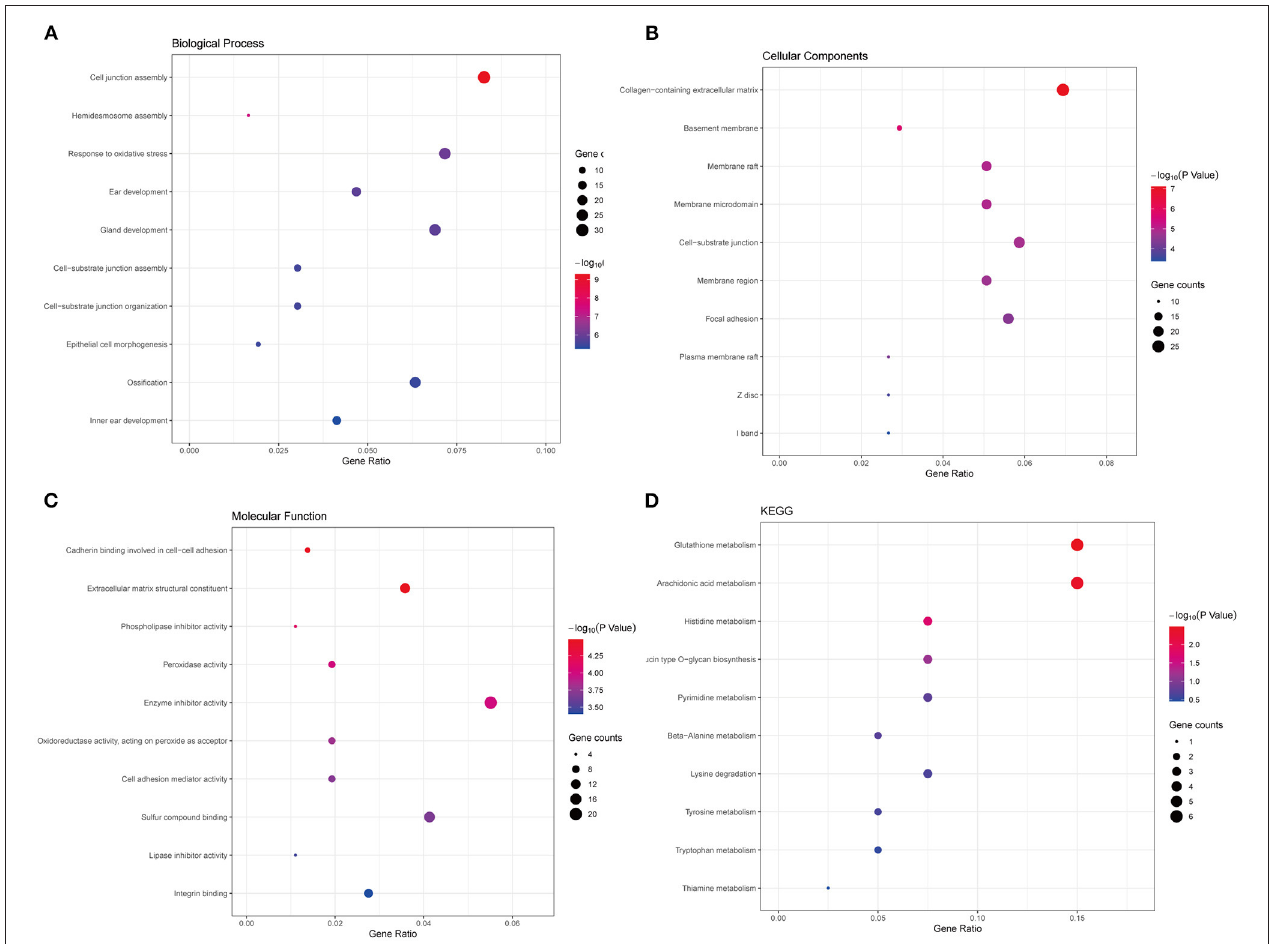
FIGURE 2 | Functional enrichment analyses of the common DEGs. (A) The top 10 significantly enriched biological process terms. (B) The top 10 significantly enriched cellular component terms. (C) The top 10 significantly enriched molecular function terms. (D) The KEGG pathway analysis of the common